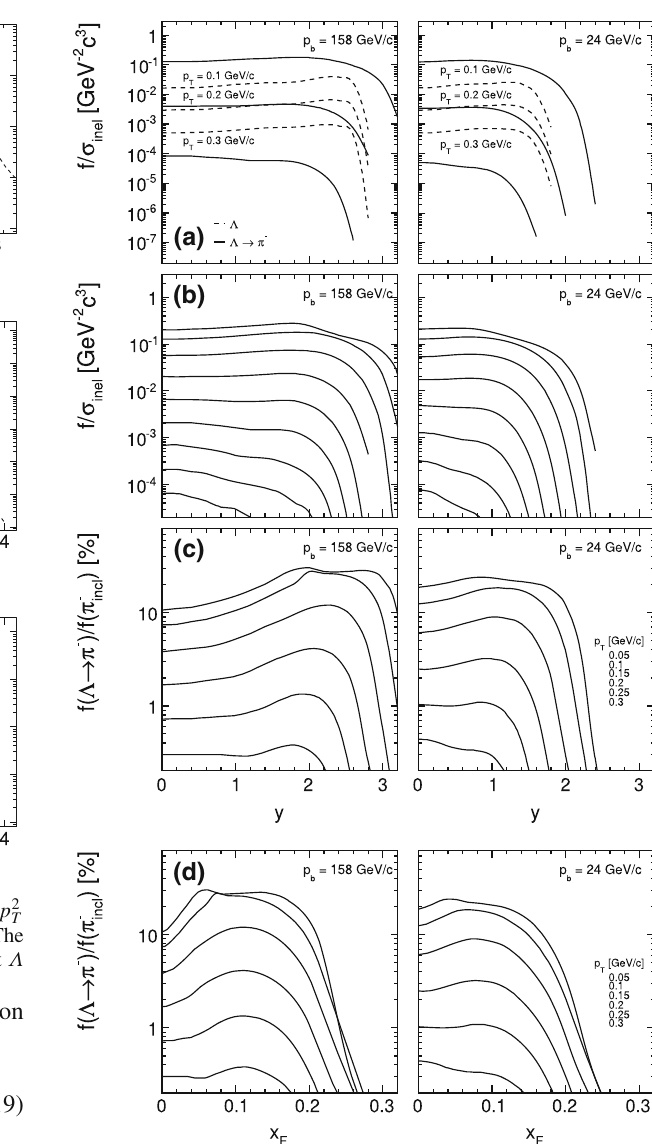
Fig. 21 a Invariant π − crosssection f /σ inel from Λ decayasafunction of y for four values of p T at 158 and 24 GeV/c beam momentum. Full lines for decay π − and broken lines for the parent Λ . Subsequent p T values are multiplied by 1/5 for clarity; b invariant π − cross section f /σ inel from Λ decay as a function of rapidity for p T between 0.05 and 1.3 GeV/c; c percentage ratio of the total π − from Λ decay to the inclusive, feed-down subtracted π − yield; d same as c but as a function of x F “thermal” behaviour, the shapes are in general not exponen- tial. There are marked differences between 158 and 24 GeV/c beam momentum and between the particle species.These dif- ferences increase for the decay pions where the m T distribu- tions are in general much steeper. This is borne out quantita- tively by the inverse slopes as a function of m T − m (Fig. 26). For the parent particles there is a wide range of “Tempera- tures” both regarding the m T and particle type dependences, superimposed to a strong variation with beam